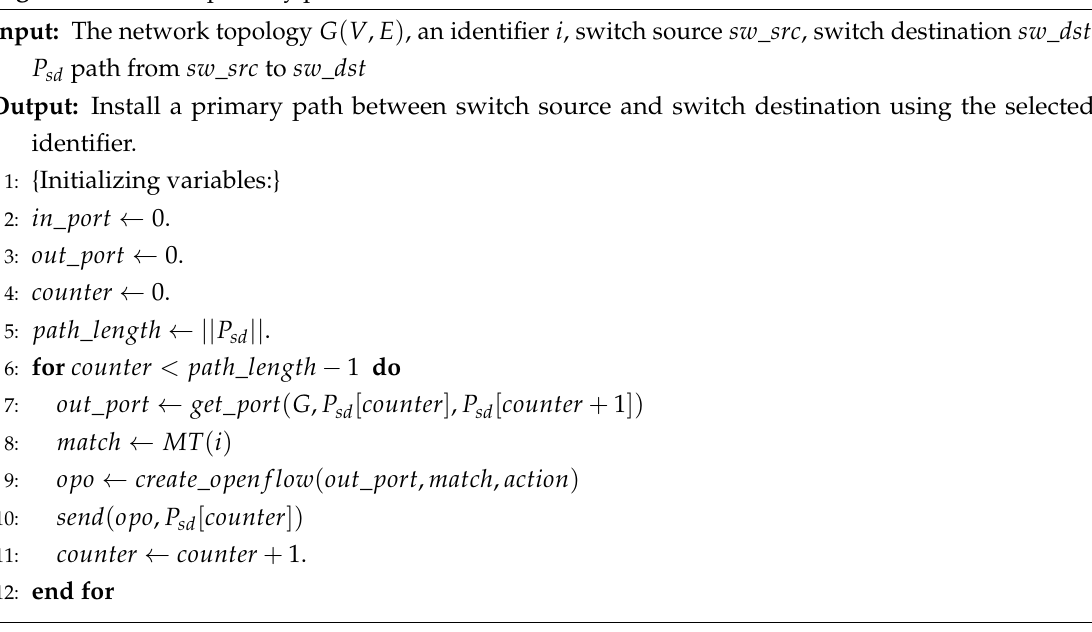
Algorithm 2 Install primary path.